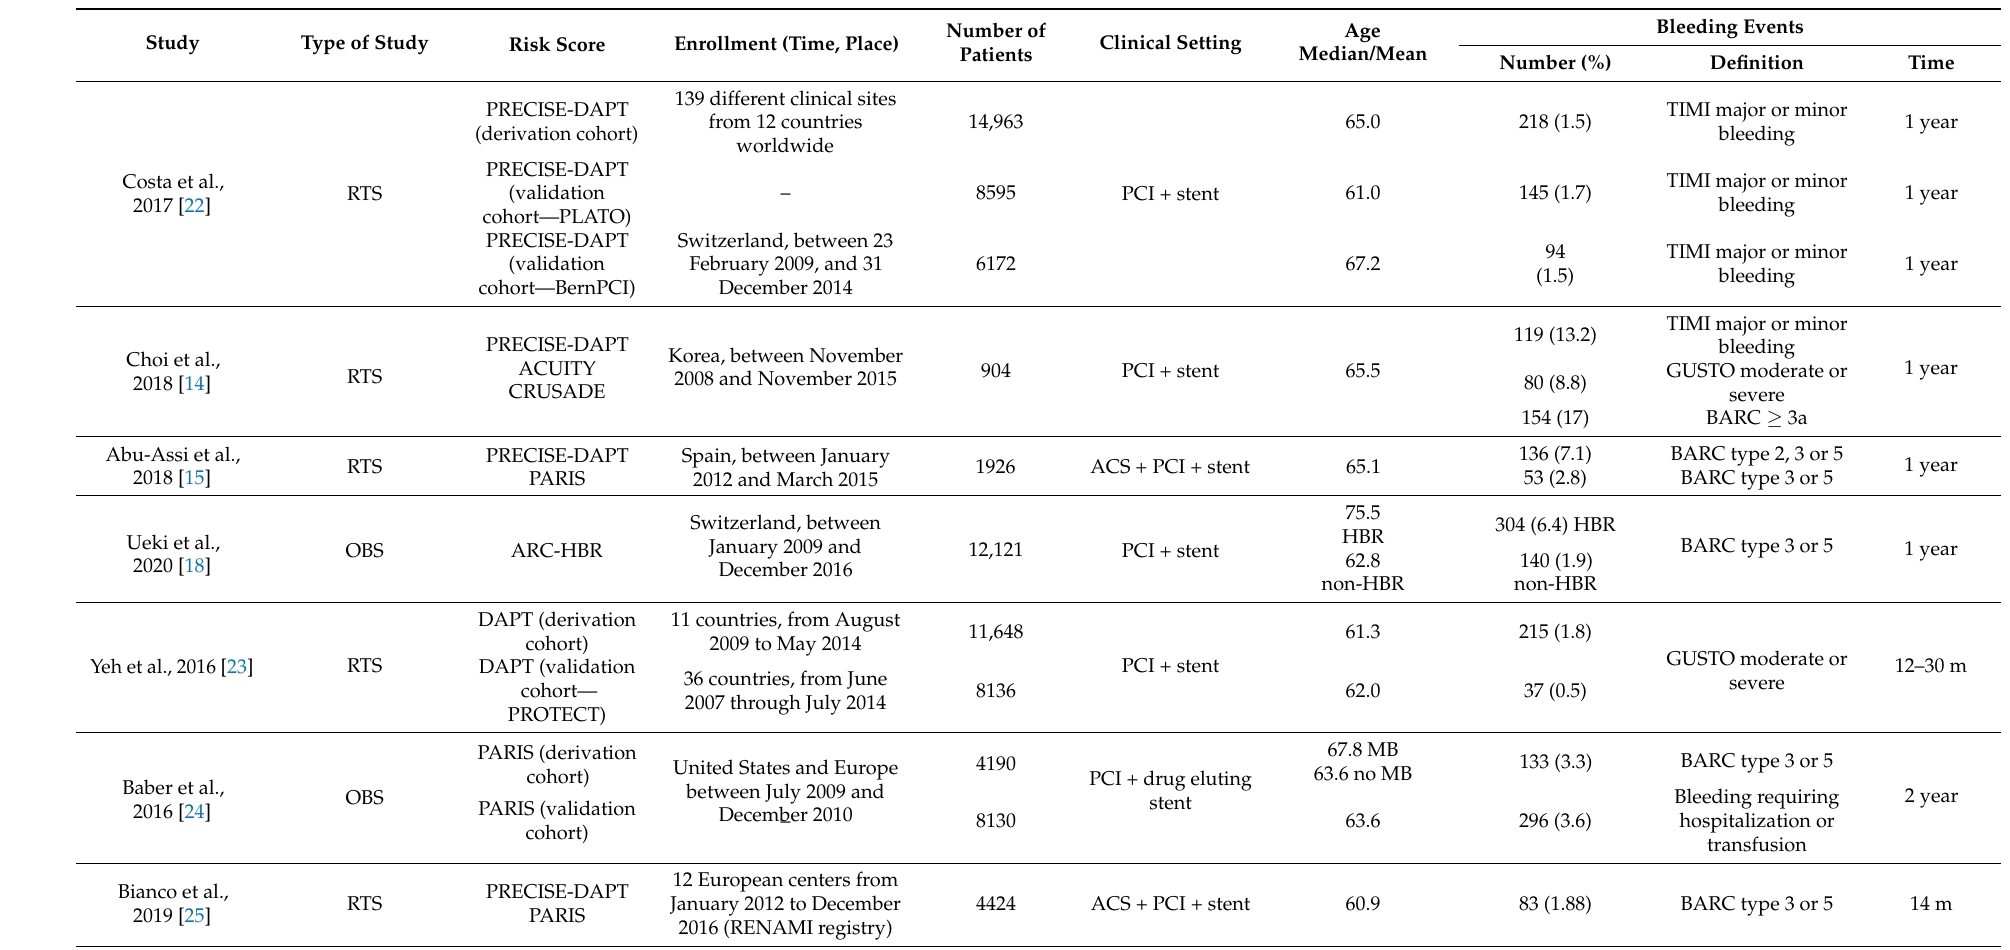
Table 1. General characteristics of studies included in present systematic